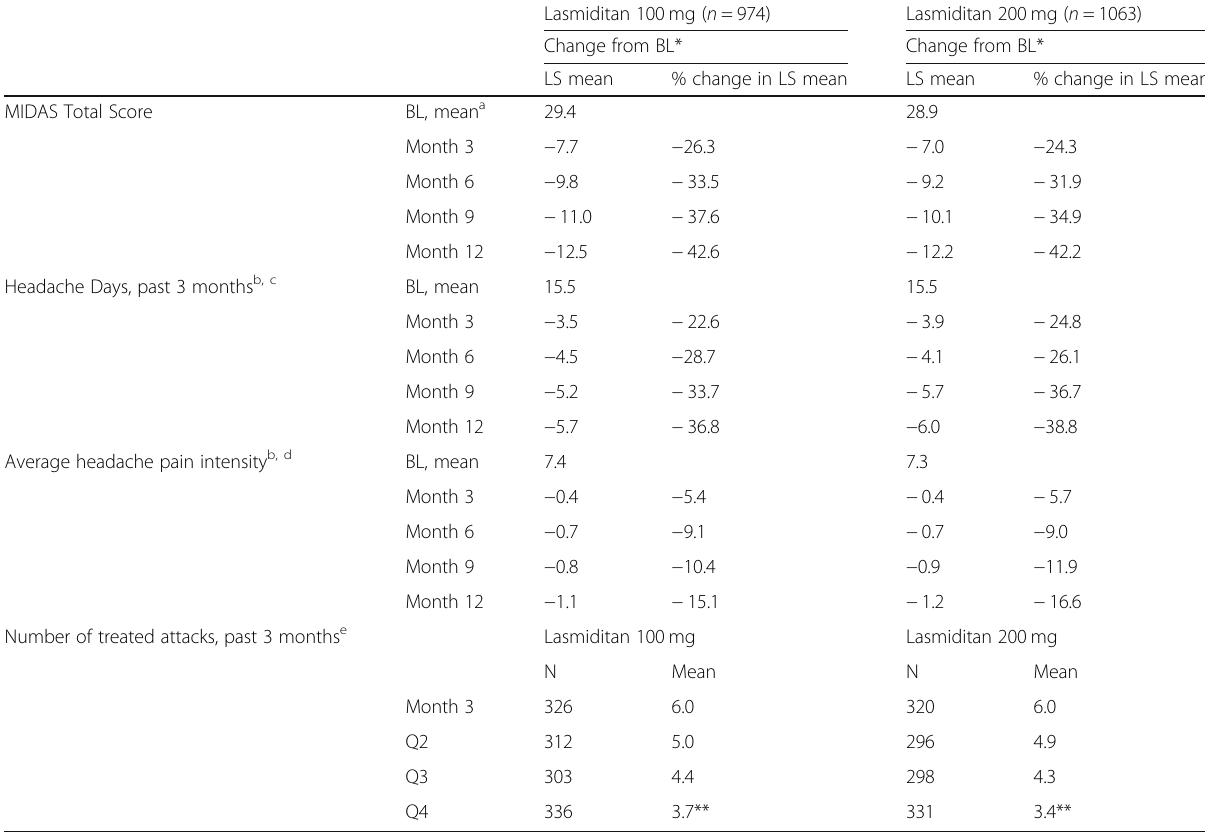
Table 2 Overall change from baseline in MIDAS total score, headache days, headache pain, and number of treated attacks for patients who completed all 4 quarters of